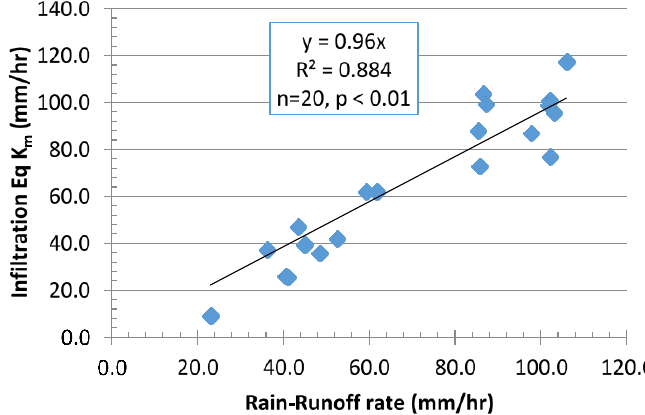
Figure 5. Dependence of Infiltration Equation K m values on Rain–Runoff rates for volcanic soil RS plots having runoff. plots having